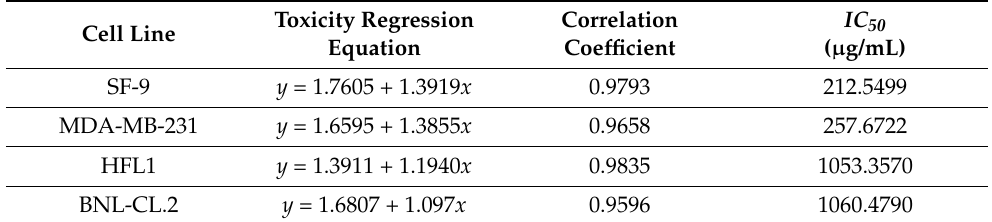
Figure 5. Clove bud essential oil (CBEO) affects the viability of SF-9, BNL-CL.2, HFL1, and MDA-MB-231 cells. Cellular toxicity of CBEO to ( A ) MDA-MB-231 cells, ( B ) SF-9 cells, ( C ) BNL-CL.2 cells, and ( D ) HFL1 cells. Each bar represents the mean ± SEM of three replicates. Different lowercase letters denote significant differences (ANOVA, p < 0.05). Table 1. Assessment of cytotoxicity of CBEO against SF-9, BNL-CL.2, HFL1, and MDA-MB-231 cells for 24 h.